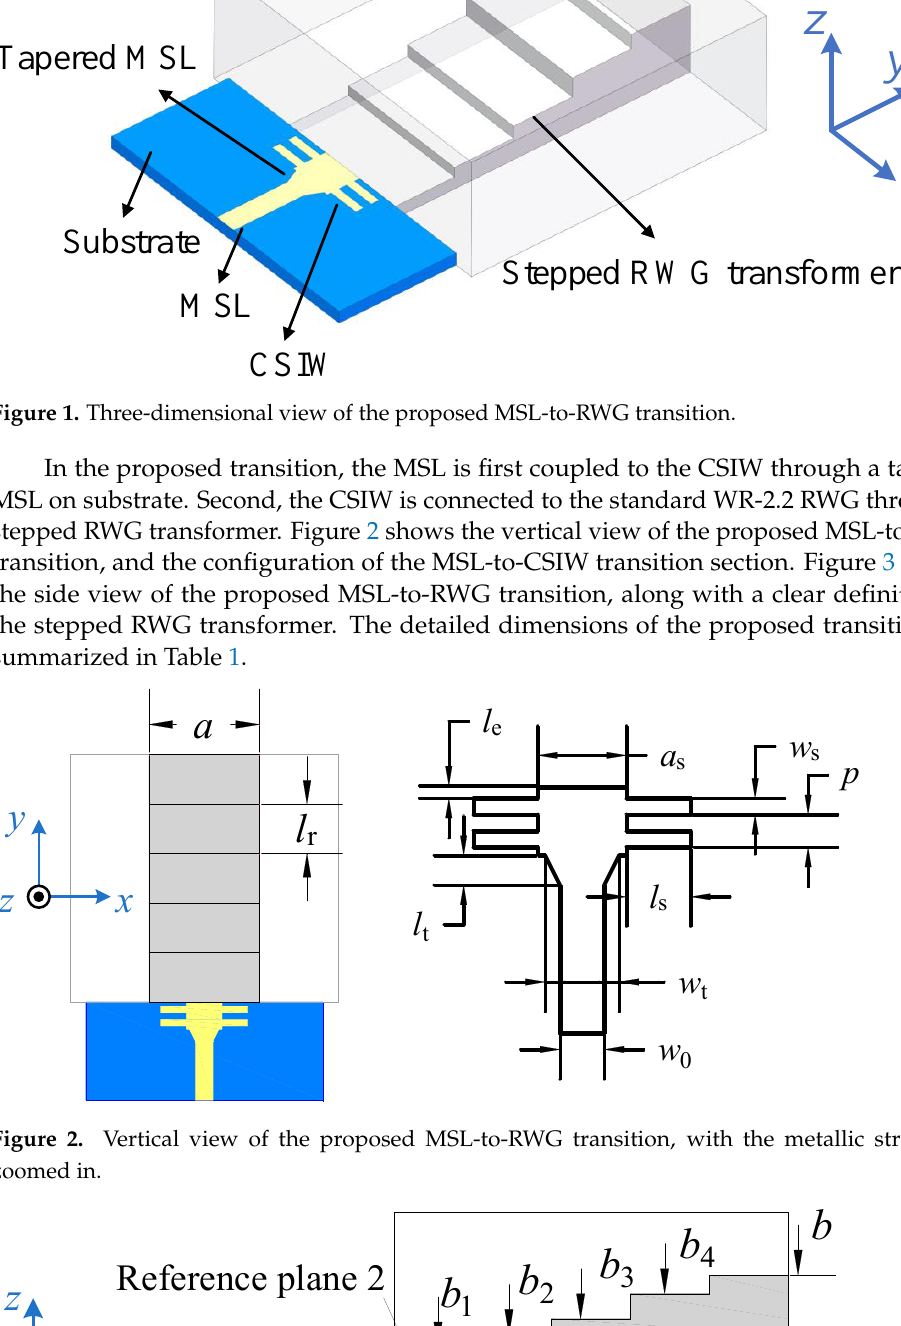
Figure 3. Side view of the proposed MSL-to-RWG transition, and the definitions of two reference planes, named Ref. plane 1 and Ref. plane 2, respectively. Table 1. Dimensions of the proposed MSL-to-RWG transition (unit: mm).